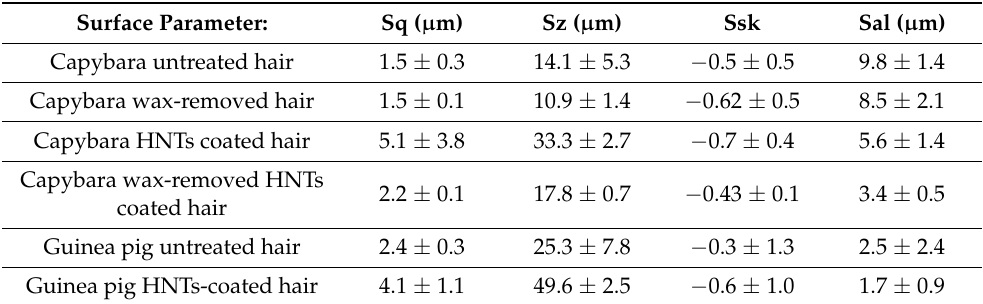
Table 1. Microscale surface texture parameters in pristine and halloysite-treated hair, coated with halloysite (HNT). Sq (root mean square height if roughness); Sz (maximum roughness height); Ssk (Skewness); Sku (kurtosis-deviation from Gauss distribution; Sal (autocorrelation length); Str (texture aspect ratio); Sdr (developed interfacial area ratio).